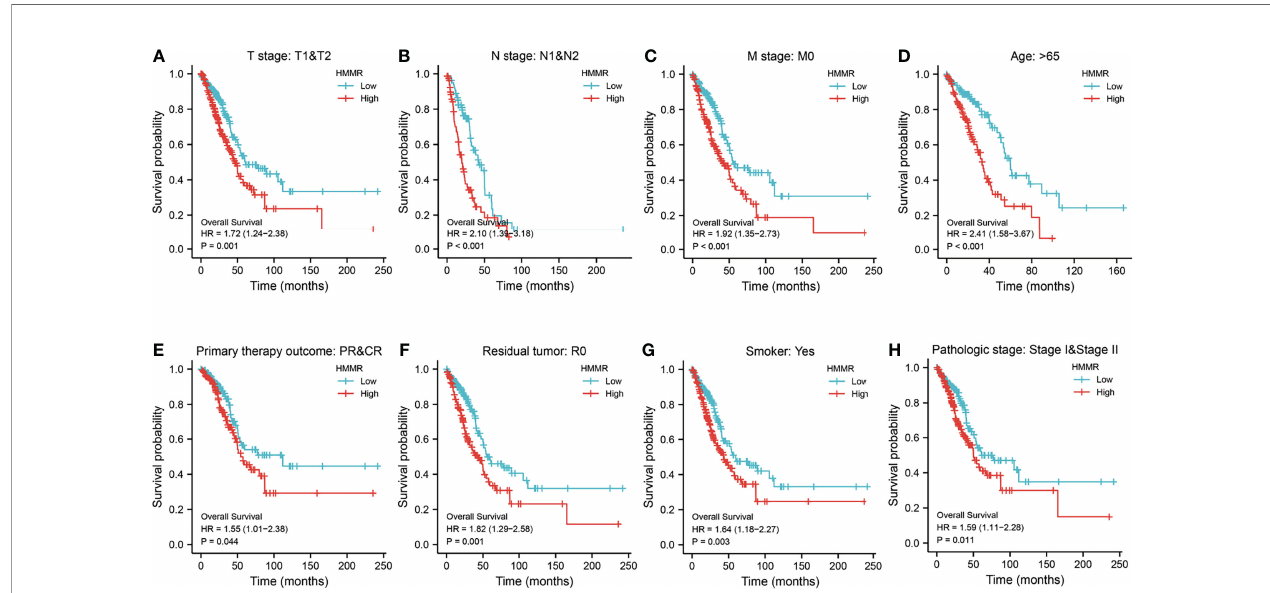
FIGURE 4 | Prognosis of hyaluronan-mediated motility receptor ( HMMR ) based on different subgroups. (A – H) Prognosis of HMMR based on TNM stage, age, pathologic stage, and smoking